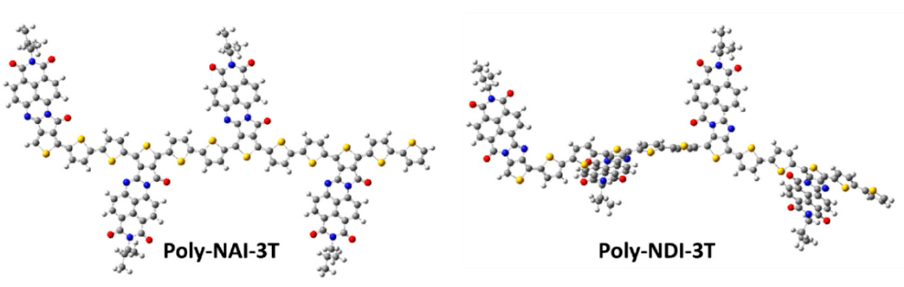
Figure 11. Geometry optimization obtained by DFT/B3LYP/6-31G** theoretical calculations for Poly(NAI-3T) and Poly(NDI-3T) .